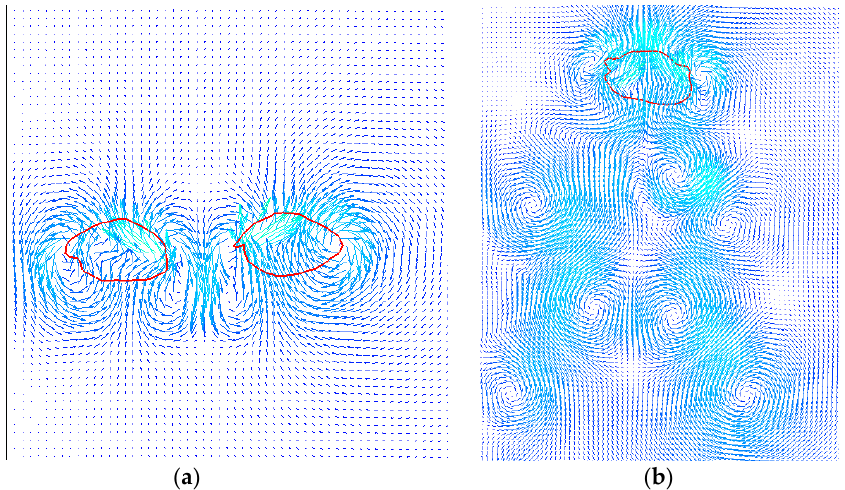
Figure 17. The flow field distribution diagram of the horizontally arranged near ‐ wall double bub ‐ bles at the initial stage of rise and after the coalescence: ( a ) Bubbles before merging, ( b ) The merged bubbles. (2) Double bubbles arranged horizontally at 3 times diameter spacing Error! Reference source not found. is the rising deformation diagram of the horizon ‐ tally arranged double bubbles with the bubble spacing of 3 times the bubble diameter. It can be seen from the figure that the two bubbles did not coalesce, and the interaction be ‐ tween the bubbles became smaller due to the increase in the distance between the bubbles. So unlike the previous article, the bubbles are far away from each other, The left bubble